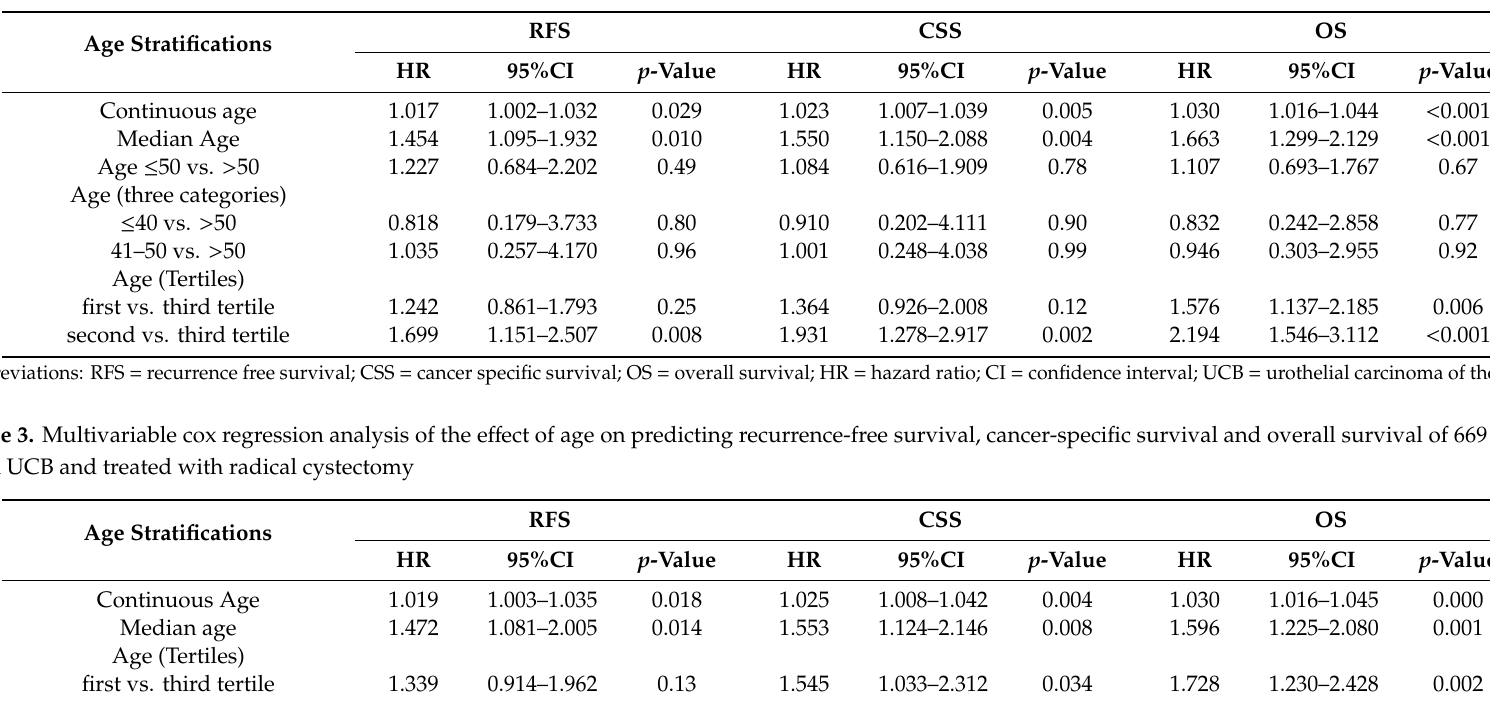
Table 2. Univariable cox regression analysis of variable age stratifications predicting recurrence-free survival, cancer-specific survival and overall survival of 669 patients with UCB treated with radical cystectomy